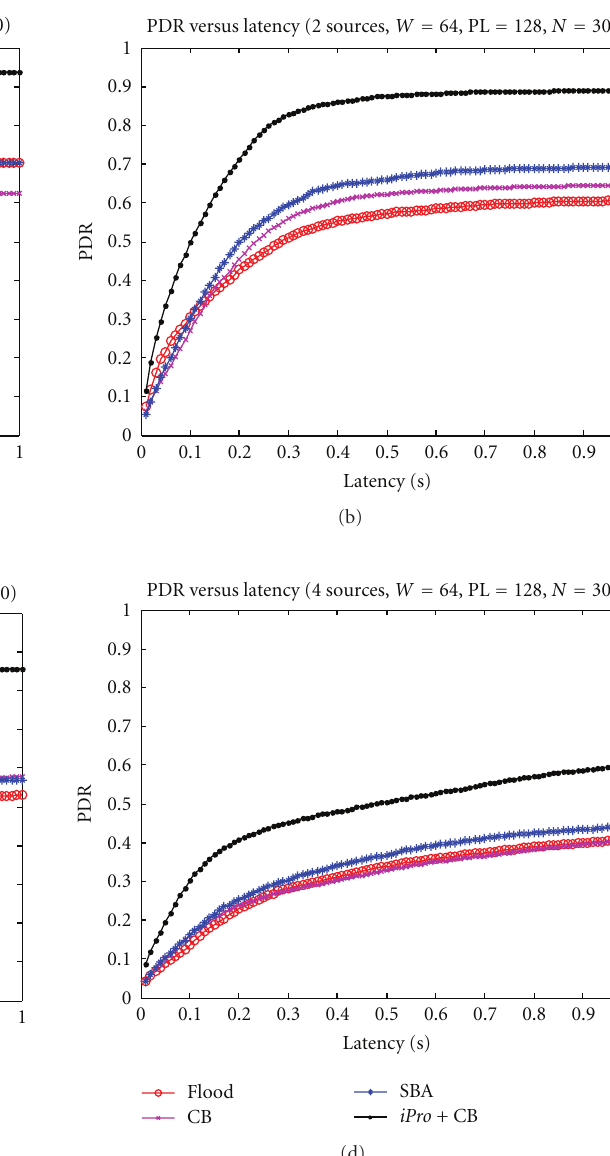
Figure 9: Latencies versus PDRs in multisource multihop broadcast